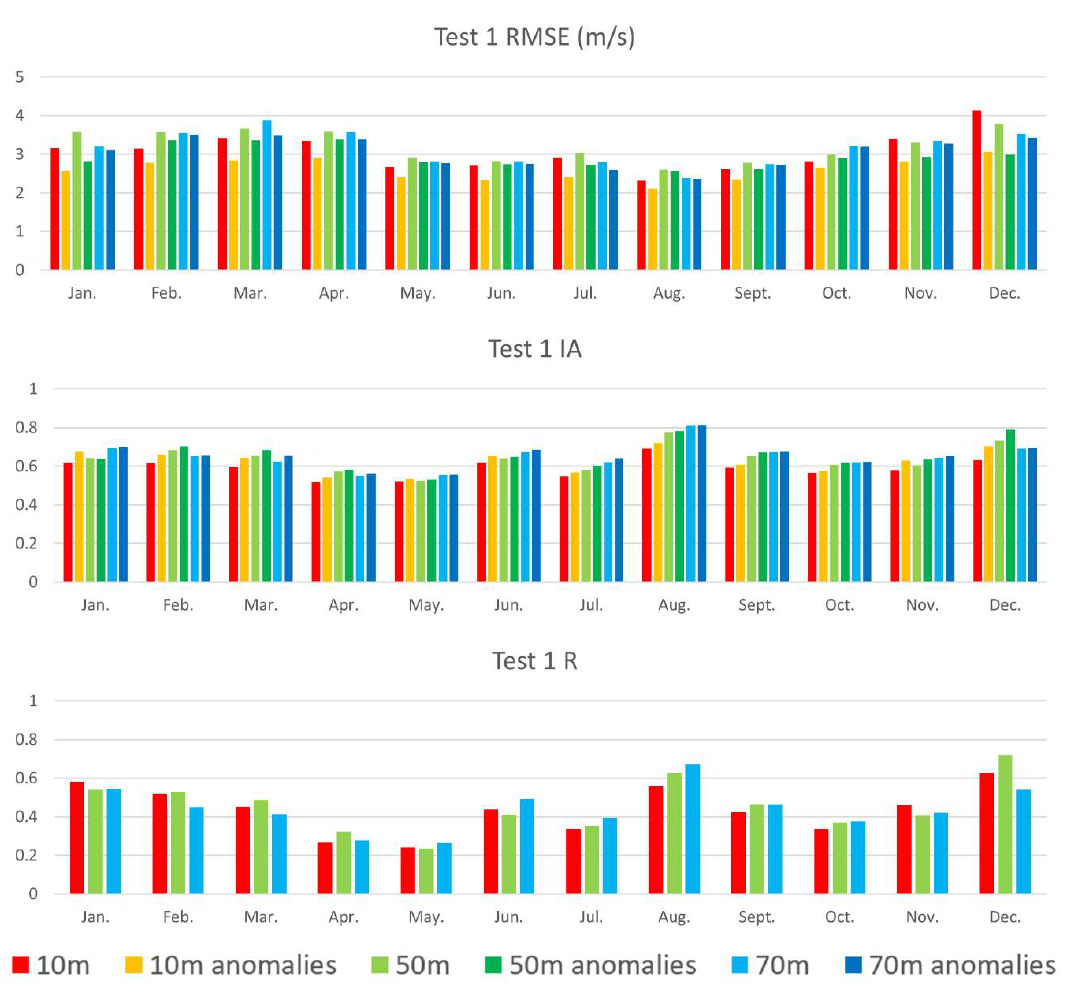
Figure 8. Average results of root-mean-square error (RMSE), index of agreement (IA), and correlation coefficient (R) in Test 1; “10 m”, “50 m”, “70 m” are the RMSE, IA, and R results of wind speed at 10, 50, and 70 m, and the “anomalies” histograms are the results of RMSE, IA, and R, calculated using wind speed anomalies.